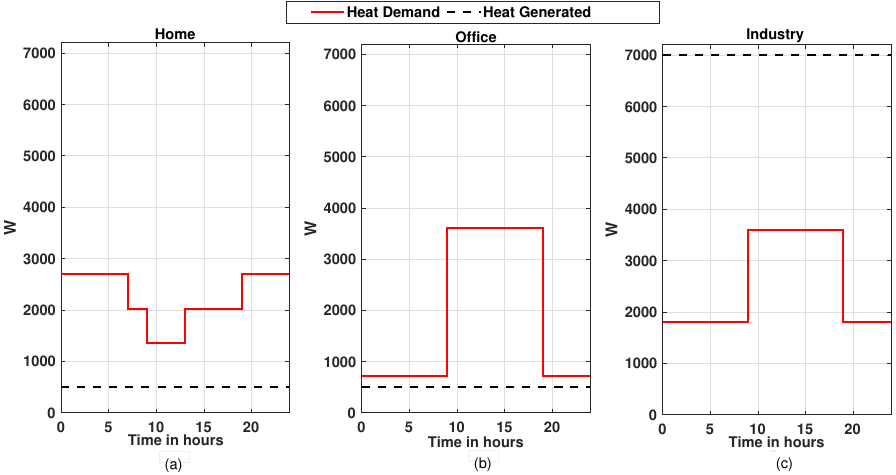
Figure 5. Heating demand and generation of 24 h for the month of November, ( a ) for the home building, ( b ) for office building, and ( c ) for industry building.